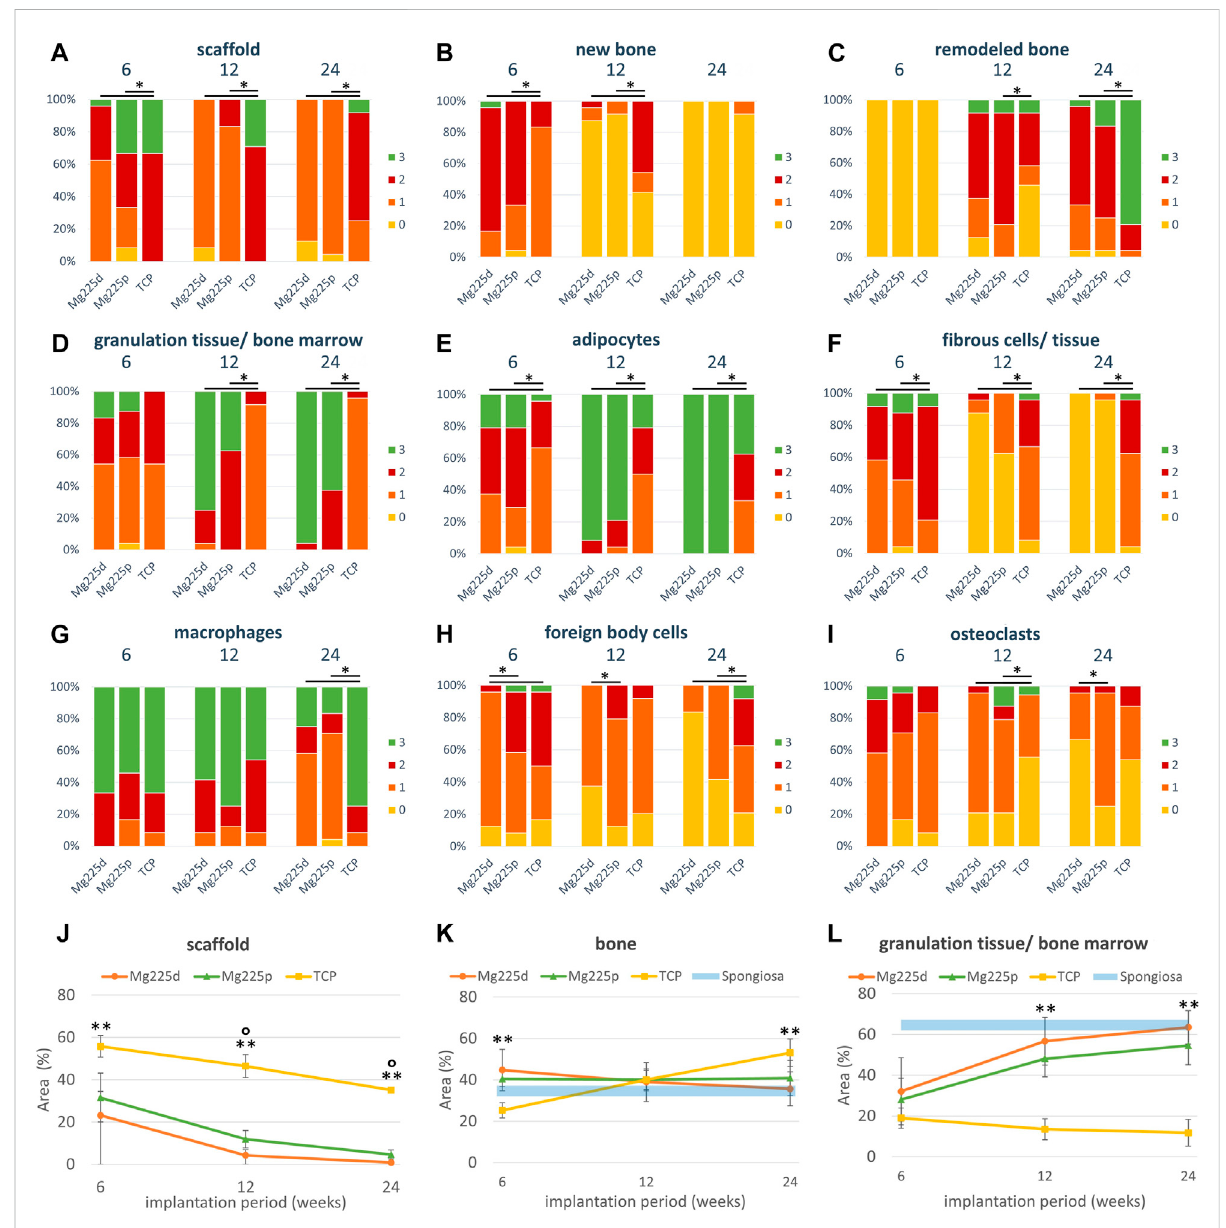
FIGURE 9 (A – I) Semi-quantitative histologicalevaluationofthescaffoldsand theingrowingtissue (A – E) attissuelevel and (F – I) atcell levelafter 6,12 and 24 weeks.*:Signi fi cantdifferences( p < 0.05)betweentheindividualmaterials. (J – L) Histomorphometricmeasurementofthepercentageareaof (J) scaffold, (K) bone and (L) granulation tissue/bone marrow in the scaffold cross section ( Ø = 1,060 pixels a diameter of the OR of the